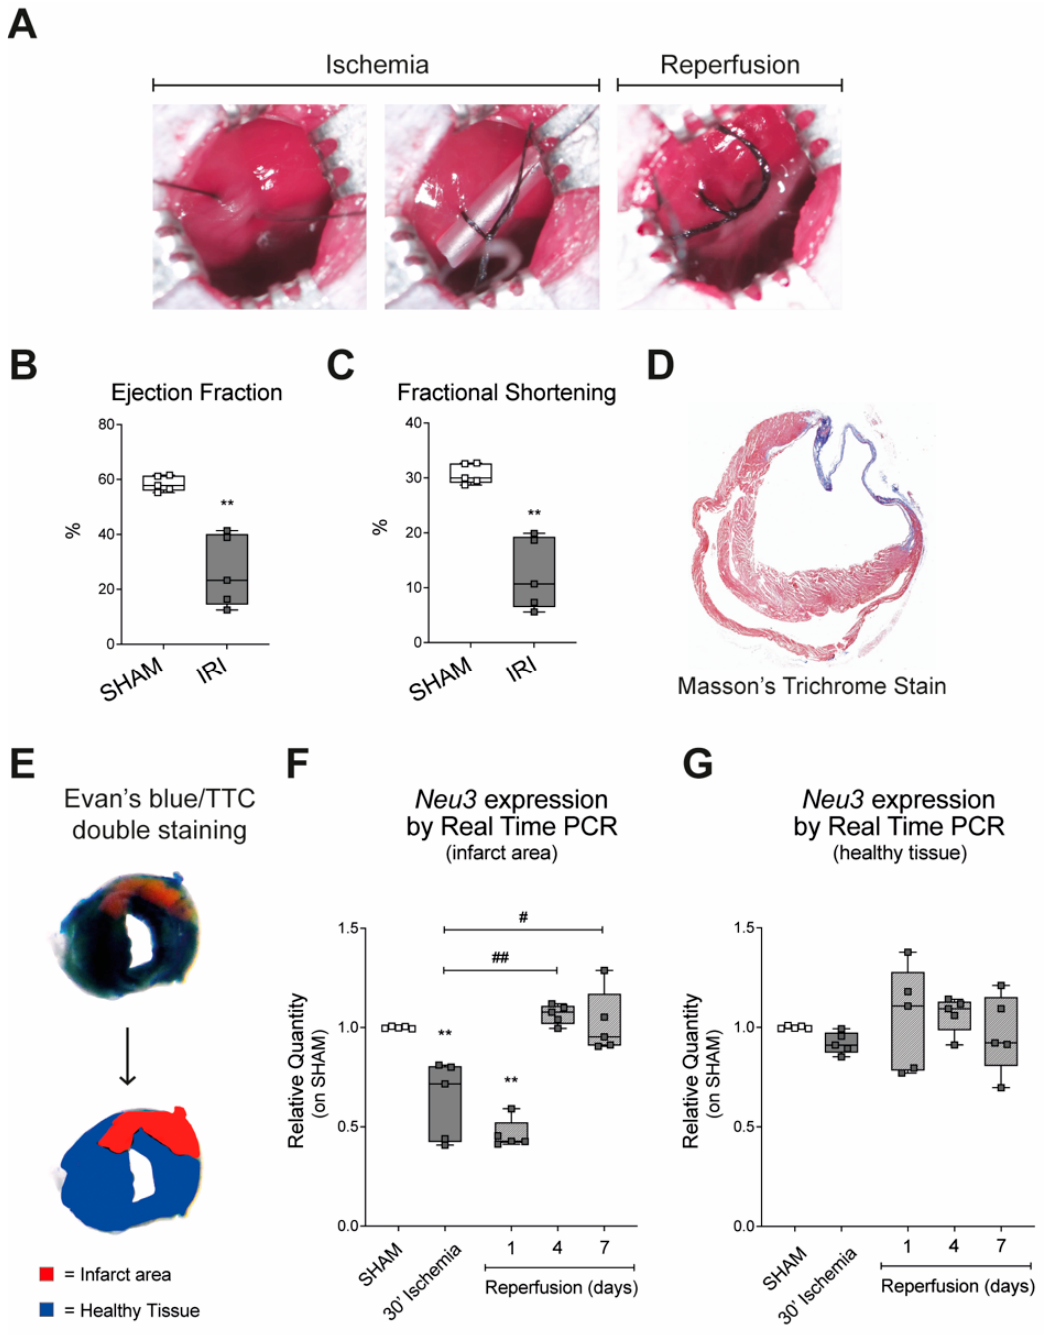
Figure 1. Effects of ischemia and reperfusion exposure on the expression of sialidase Neu3 . ( A ) Ischemia and reperfusion injury in vivo model obtained by temporary ligation of the left anterior descending coronary vessel; ( B , C ) cardiac function was assessed by echocardiography. Ejection fraction ( B ) and fractional shortening ( C ) are shown as percentages, in comparison between sham and animals subjected to IRI. ( D ) Morphological cardiac analysis to assess fibrotic scarring with Masson’s trichrome staining; ( E ) Evan’s blue/TTC double staining schematic representation; ( F ) sialidase Neu3 expression in the infarcted area measured by Real Time PCR ( G ) sialidase Neu3 expression in healthy cardiac tissue measured by Real Time PCR. Data are expressed as relative amounts compared with sham animals. Each square in the graphs represent a single animal. Statistical significance was determined by the nonparametric Kruskal-Wallis test.; ** p < 0.01. The # symbol indicates the statistical significance as compared to 30 ′ ischemia: # p < 0.05; ## p < 0.01. 2.2. Effects on Cell Proliferation, Toxicity and Neu3 Expression of an In Vitro Model of IRI To investigate the role of sialidase-3 during IRI, a simple in vitro model of IRI was developed in our laboratory by culturing H9c2 rat cardiomyoblasts at 1% O 2 in DMEM without glucose for up to 12 h ( ischemic phase ), followed by a switch to complete growth medium under 21% O 2 for up to 48 h ( reperfusion phase ) (Figure 2A). Control cells were cultured under normoxic conditions in a complete growth medium throughout the experiments. Results showed that the ischemic phase caused a significant cell loss and reduction in proliferation ( − 70% at 12 h, Figure 2B) along with a significant increase in cell cytotoxicity (+4-fold at 12 h, Figure 2C), with both effects reversed during reperfusion (Figure 2B,C).